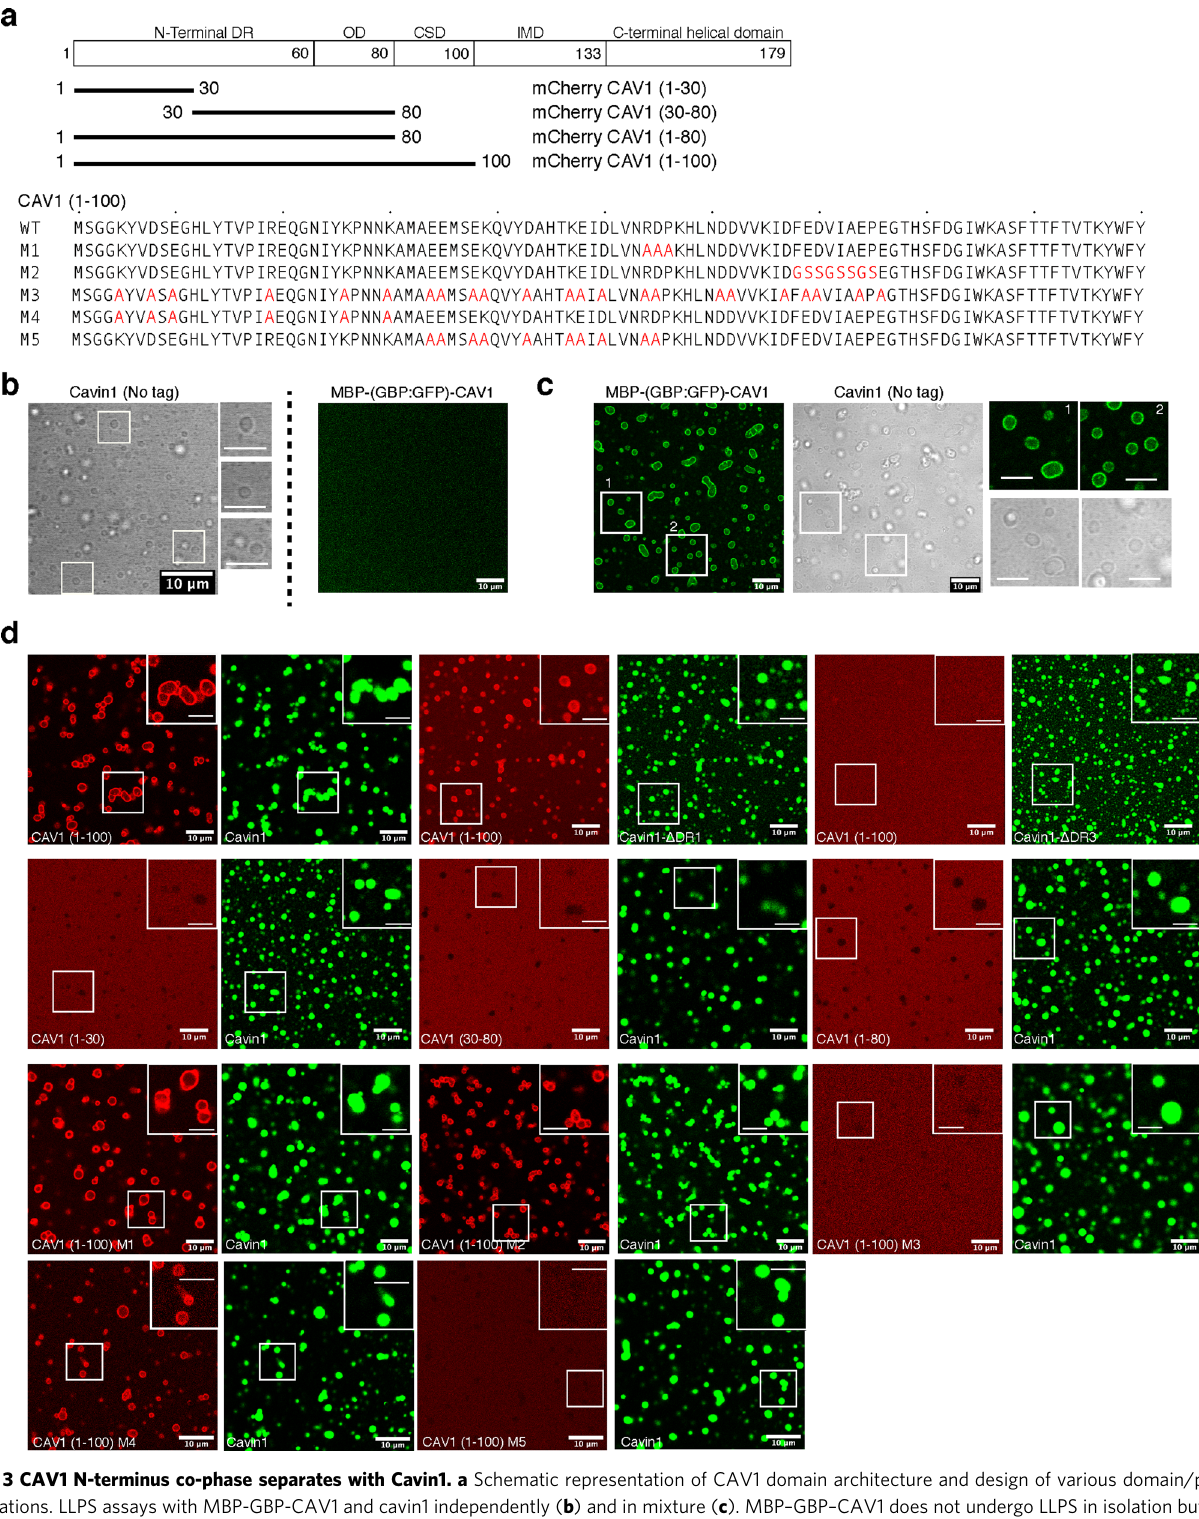
NATURE COMMUNICATIONS| (2021) 12:931 |https://doi.org/10.1038/s41467-021-21035-4|www.nature.com/naturecommunications